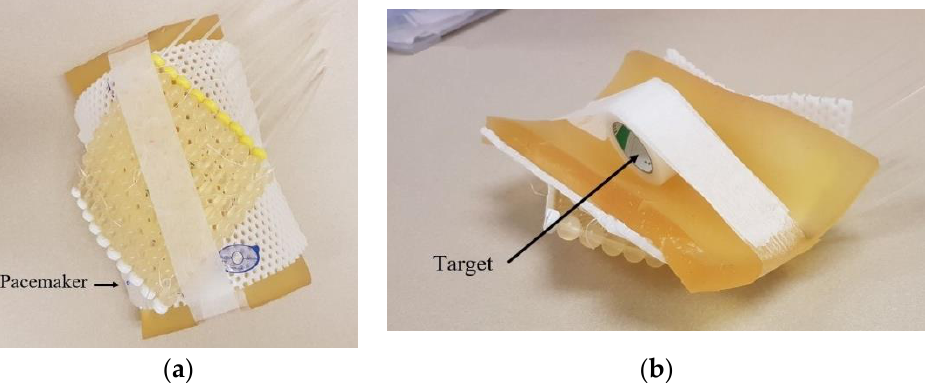
Figure 7. The phantom used to test OSLDs using a Freiburg flap applicator. ( a ) Top view of the phantom indicating the position of the pacemaker; ( b ) Bottom view of phantom indicating the position of the target.